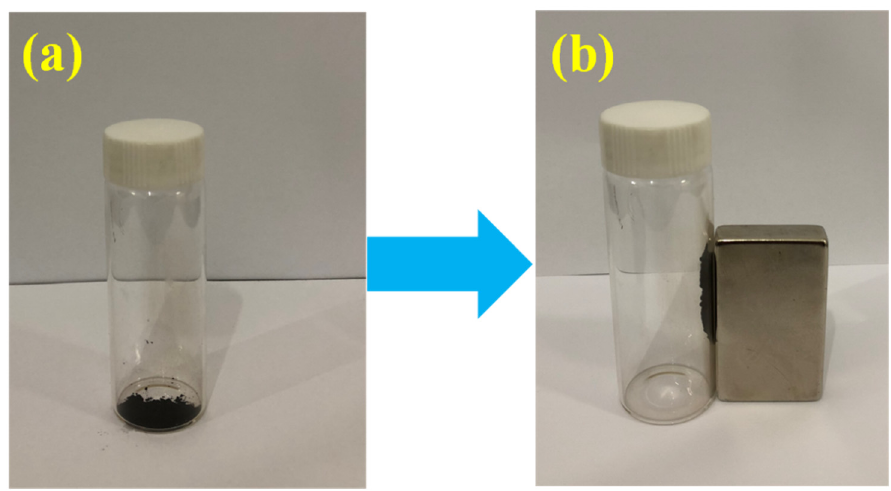
Figure 3. Digital photographs ( a) Fe 3 O 4 nanoparticles ( b ) the magnetic test by magnet for Fe 3 O 4 nanoparticles.